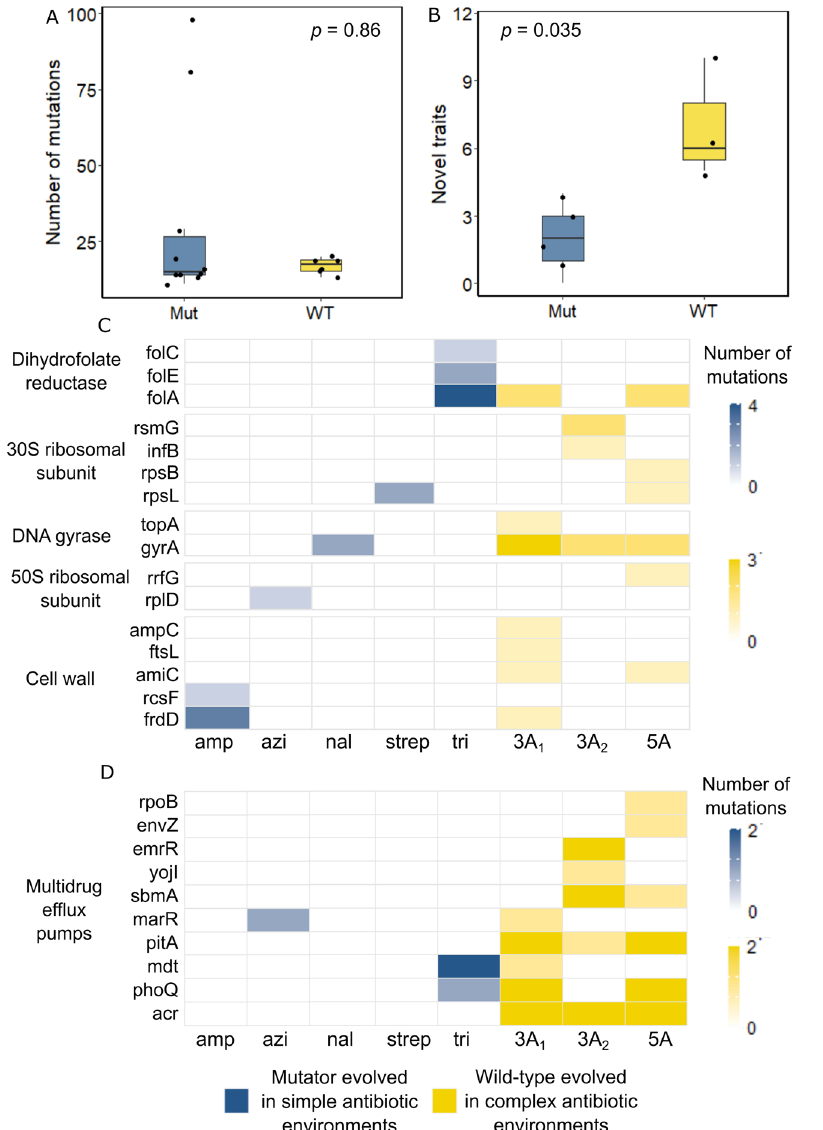
Fig. 3 | The nature of retained genetic variation differs between populations evolved in simple and complex environments A. The total number of retained genomic variants was statistically indistinguishable (Two-sided Wilcoxon rank sumtest, n =10and6, W =28, p =0.86)betweenmutatorclonesevolvedinsimple antibiotic environments (blue) containing a single antibiotic, and wild-type clones evolved in complex antibiotic environments (yellow) containing three (environments3A 1 and3A 2 )or fi ve(environment5A)antibiotics. B Thenumberof evolved novel traits was signi fi cantly higher (Two-sided Wilcoxon rank sum test, n =5 and 3, W =0, p =0.035) in wild-type clones evolved in complex antibiotic environments than in mutator clones evolved in simple antibiotic environments. In the ( A , B ), the boxes represent interquartile range while the solid line repre- sentsthemedian.Thewhiskersrepresent1.5timesoftheinterquartilerange.The circleslocatedabovethetopwhiskerareoutlierswhosevaluesarehigherthan1.5